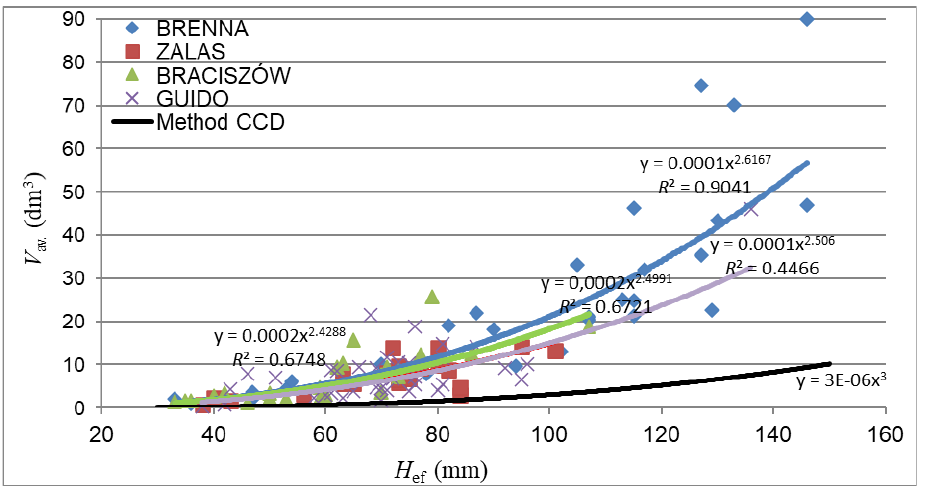
versus the effective anchoring depth H av .